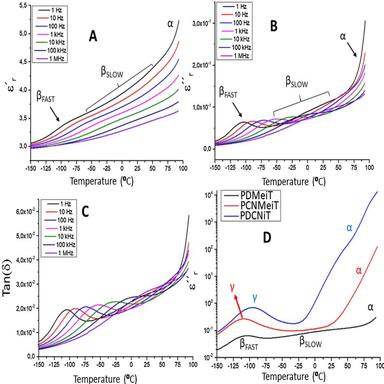
ε′ (A), ε″ (B) and tan (δ) (C) values obtained through temperature-scans for poly(dimethyl itaconate) (PDMeiT). (D) Dielectric loss comparison between PDMeiT and poly(itaconate)s synthetized in the present work.